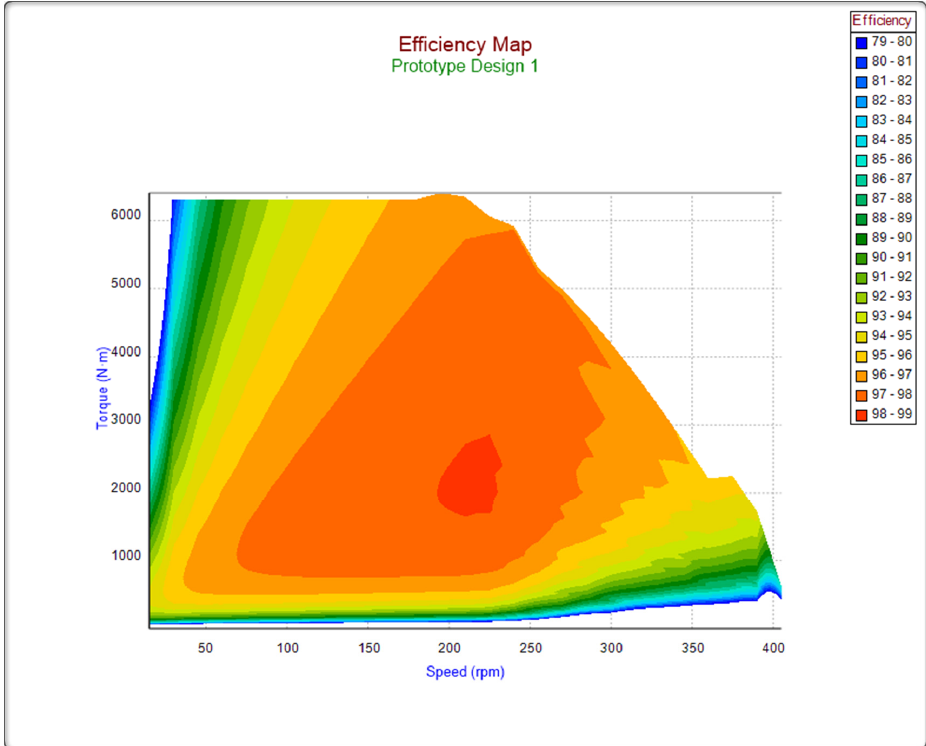
Energies 2022 , 15 , x FOR PEER REVIEW Figure 22. Voltage variation waveform. Figure 22. Voltage variation waveform.